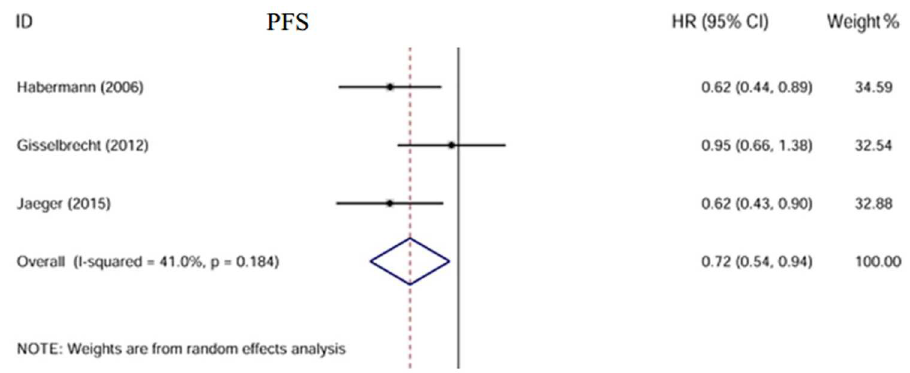
Fig 4. Forest plot of the HR. PFS is improvedin patients in the maintenance arm.